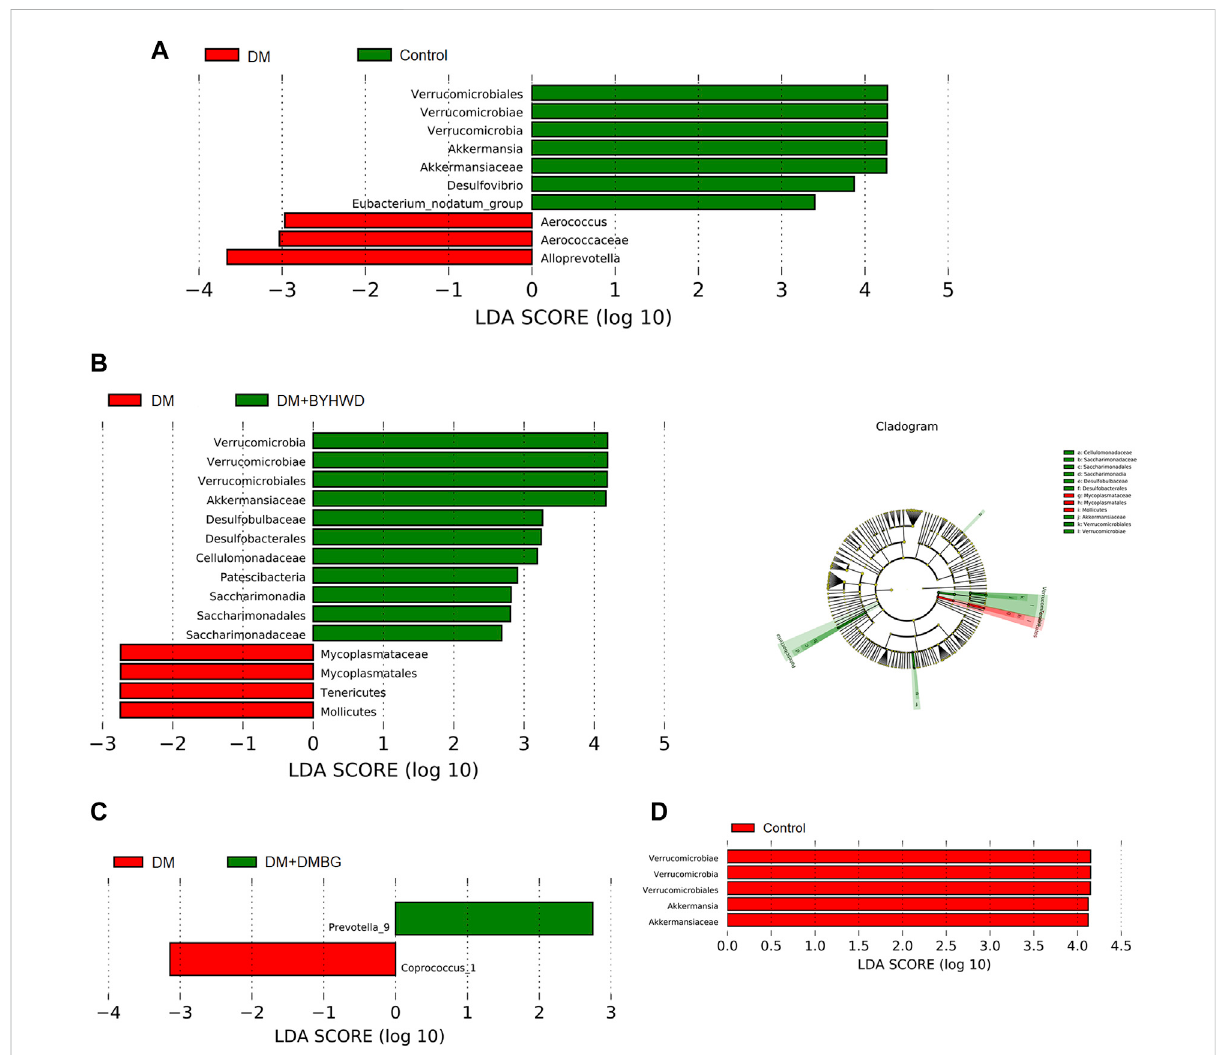
FIGURE 6 LEfSe analysis of the gut fl ora composition of the four study groups (LEfSe analysis exhibited differentially abundant taxa with p < 0.05 and LDA score > 2.0.); (A) LEfSe analysis results between the DM and control groups; (B) LEfSe analysis results between the DM and BYHWD groups; (C) LEfSe analysis results between the DM and DMBG groups; (D) LEfSe analysis results between the BYHWD and control